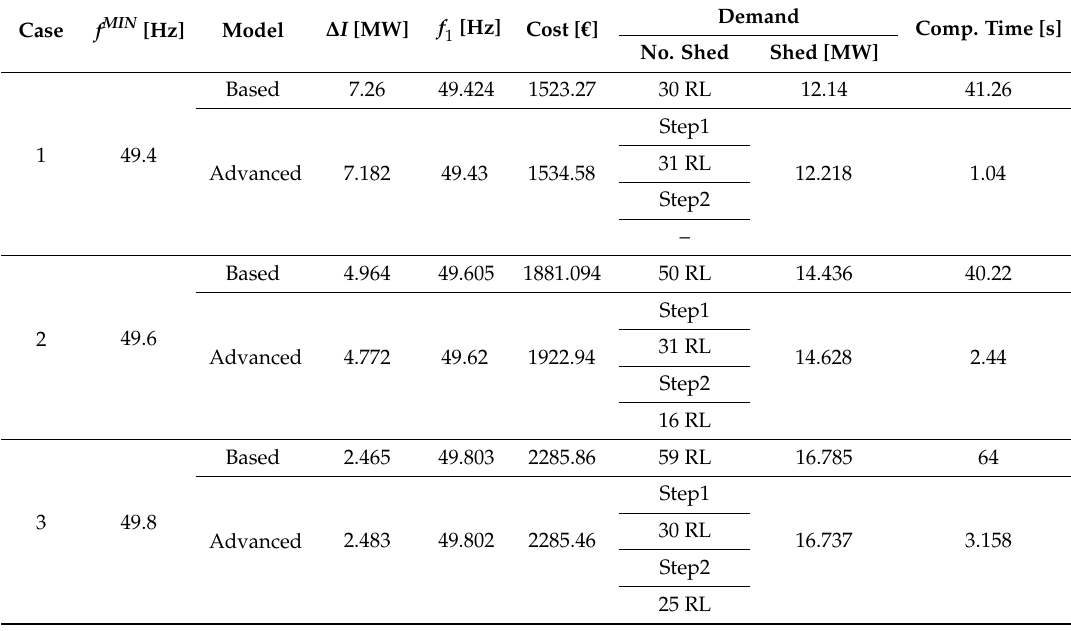
Table 4. Main results of the optimization models: the base